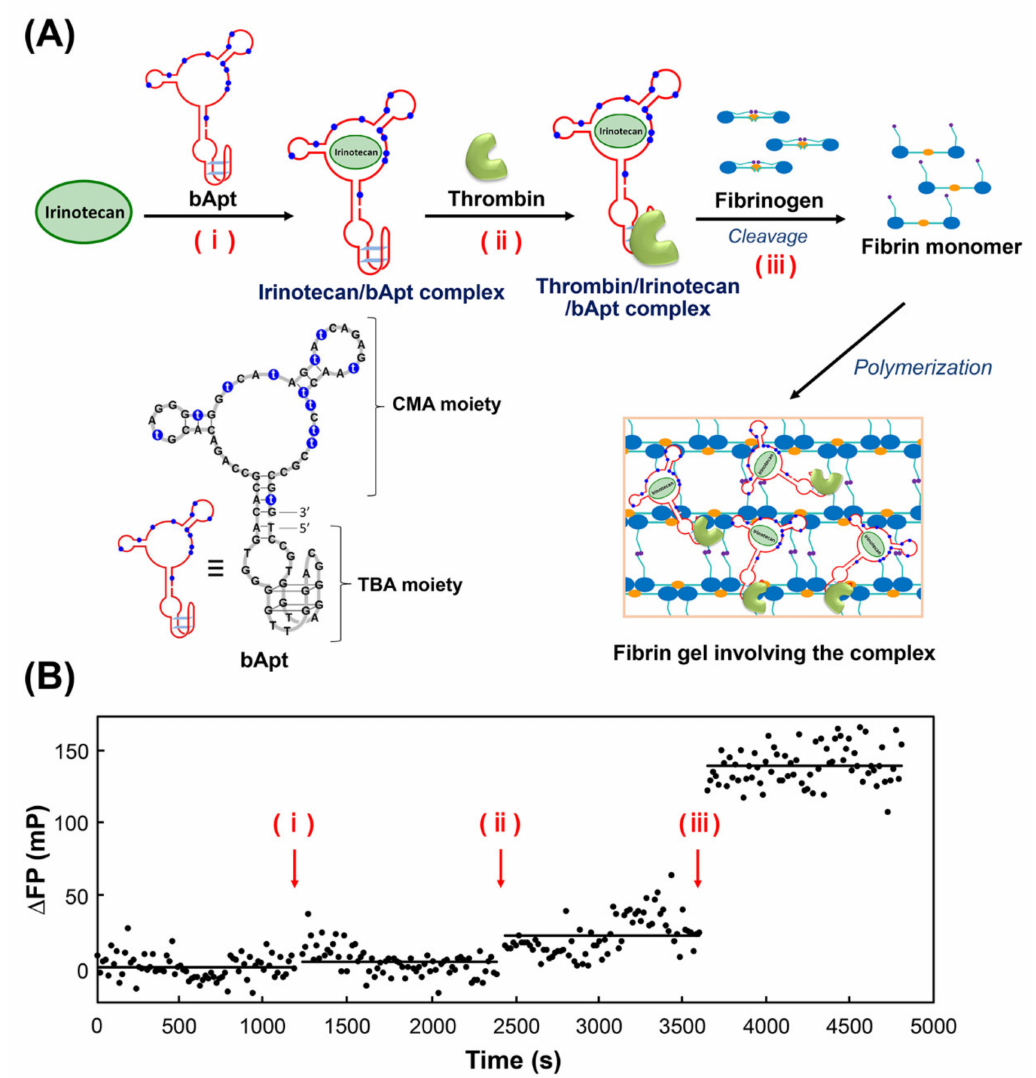
Figure 3. Mechanism of in situ condensation in fibrin gel based on the selective oligonucleotide entrapment in fibrin polymers (SOEF) phenomenon; entrapment of ( A ) the thrombin / irinotecan / bApt complex during the fibrin gel formation. ( B ) The titration curves for irinotecan polarization versus bApt concentration; polarization was monitored at 456 nm using an excitation wavelength of 372